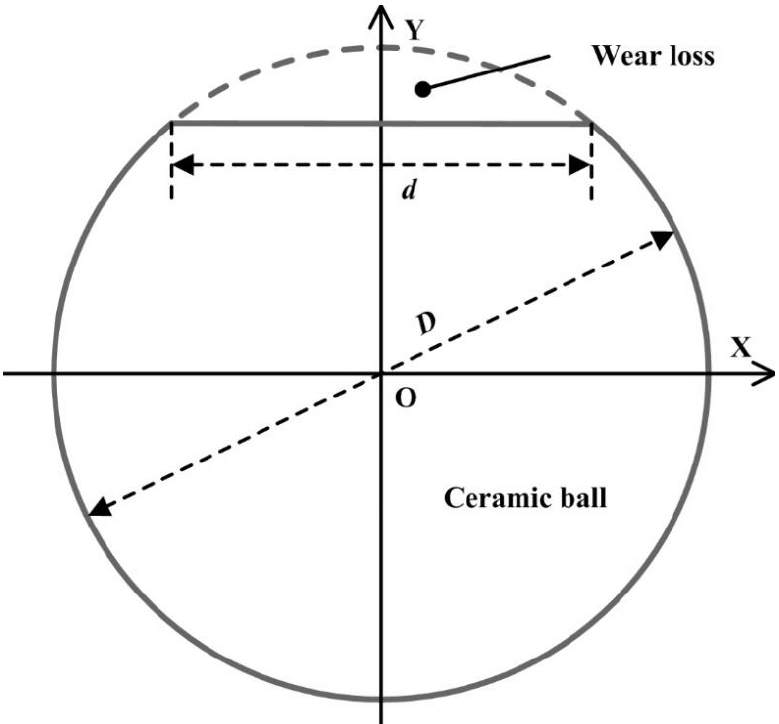
Figure 8. Schematic diagram of wear loss for the worn ceramic ball.